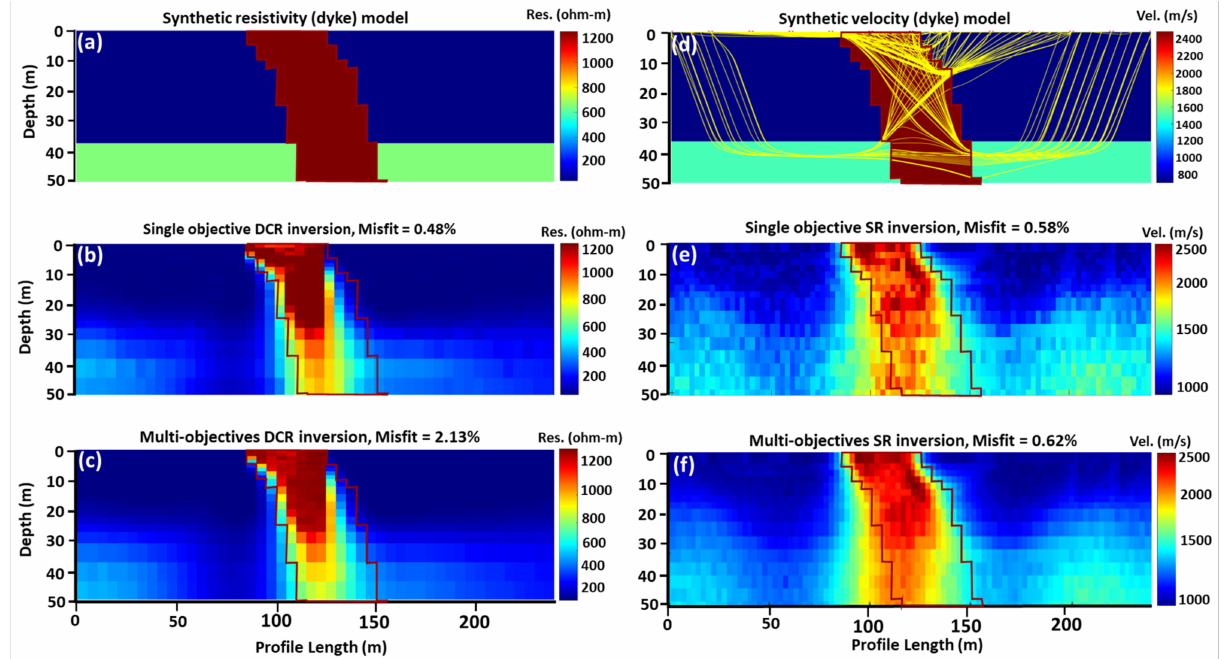
Figure 6. Dyke anomaly model inversion using combined optimization method; ( a ) synthetic dc- resistivity model, ( b ) single objective inverted resistivity model, ( c ) multi-objective inverted resistivity model, ( d ) synthetic velocity model and its ray path coverage, ( e ) single objective inverted velocity model, and ( f ) multi-objective inverted velocity model. The dark red line is used to mark the anomaly